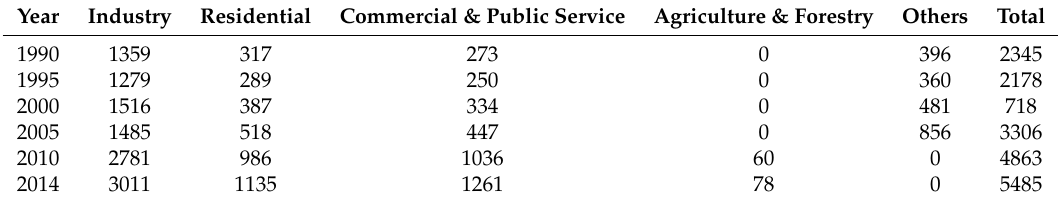
Table 2. Electricity consumption (in GWh) in Cameroon from 1990–2014. Adapted from [28].